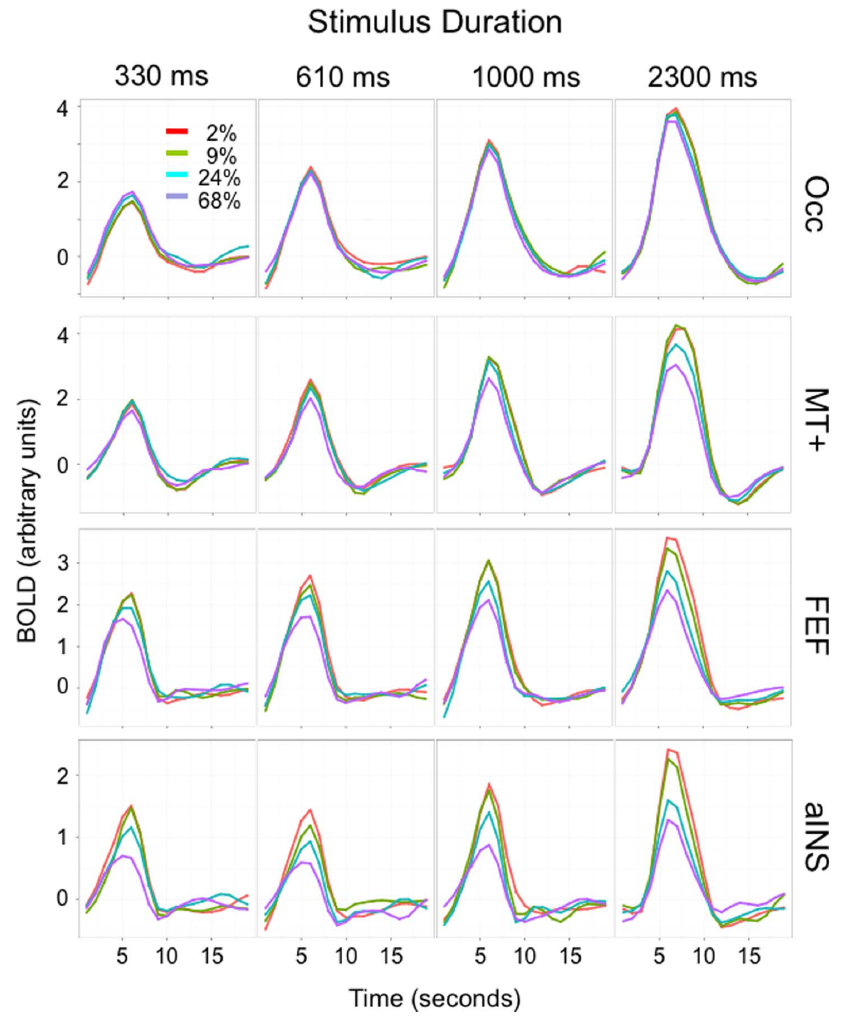
Figure 4. BOLD Time Courses. Shown here are time courses for four representative left hemisphere regions that together span the component space in figure 3E from posterior to anterior: Occ=occipital pole, MT + =middle temporal region, FEF=frontal eye fields, and aINS=anterior insula. Trials are divided into 4 duration bins (at top: 0.33s, 0.61s, 1.0s, and 2.3s) and 4 motion coherence bins (inset: 2%, 9%, 24%, and 68%).